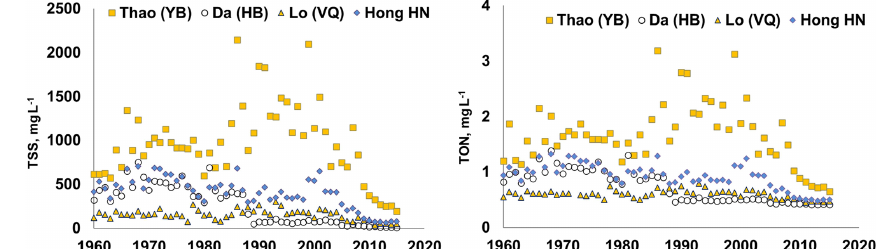
Figure 2. Annual average of TSS, TON concentrations of the Thao, Da and Lo Rivers and of the main axe at Hanoi station during different periods from 1960 to 2015. Table 2. Annual average and standard deviation of TSS fluxes (10 6 tyr − 1 ) and TON flux (10 3 tyr − 1 ) of the Thao, Da and Lo tributaries and of the whole Red River system during different periods from 1960 to